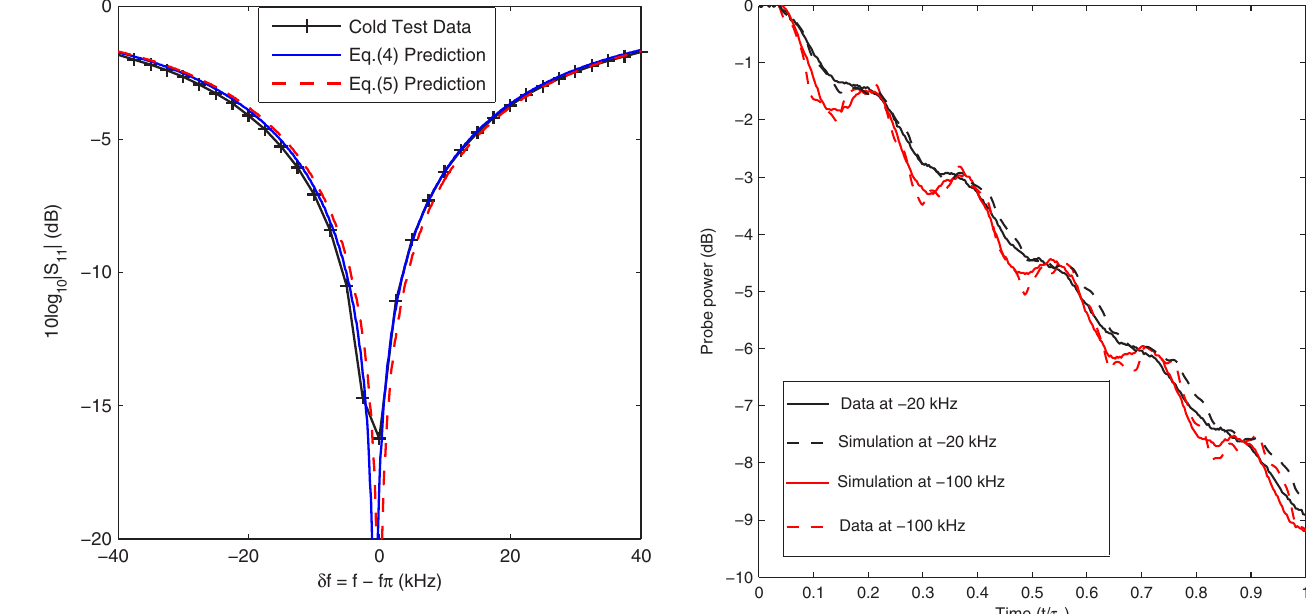
FIG. 4. (Color) Measurements and equivalent circuit model pre- dictions of the probe power after the cavity drive is tuned off. The black and red curves are for drive frequencies 20 and 100 kHz below the (cid:4) -mode frequency,